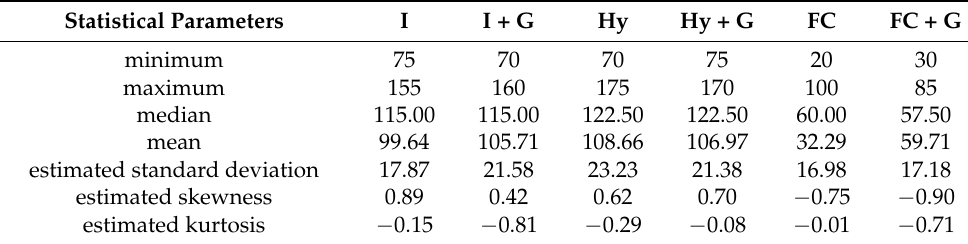
Table 2. Overview of statistical data of pore size distributions for the different non-modified and modified nonwovens is shown, namely for (I) initial state, (I + G) initial state and graphene, (Hy) hydrophilic agent, (Hy + G) hydrophilic agent and graphene, (FC) functional coating and (FC + G) functional coating and